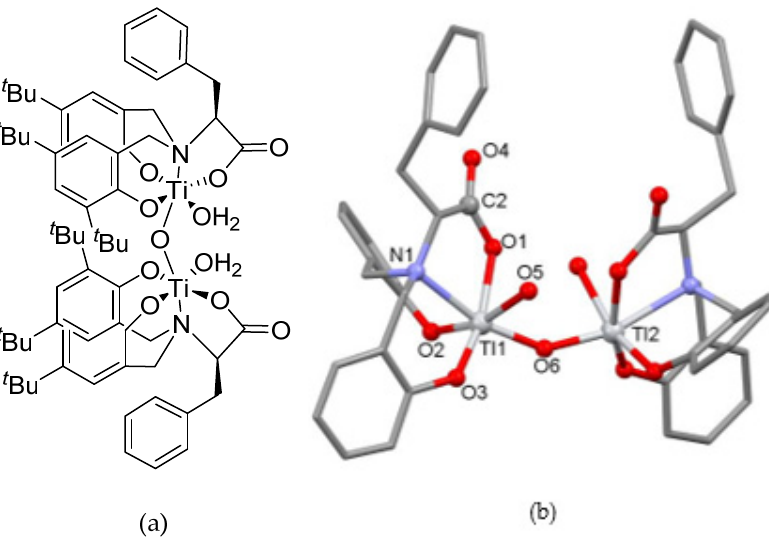
Figure 5. Ti cluster 6 ( a ), Crystal structure of 6 ( b ). Hydrogens, tert -butyl groups, and solvent omitted for clarity. Selected bond lengths for 6 (Å): Ti1-O1 2.010(7), Ti1-O2 1.872(6), Ti1-O3 1.822(6), Ti1-O5 2.145(6), Ti1-O6 1.827(6), Ti1-N1 2.289(8), Ti2-O6 1.806(6), O1-C2 1.30(1), O4-C2 1.259(13). Selected bond angles for 6 (°): O1-Ti1-O2 87.0(3), O1-Ti1-N1 75.6(3), O2-Ti1-O3 97.8(3), O2-Ti1-N1 86.9(3), Ti1-O6-Ti2 145.2(4).